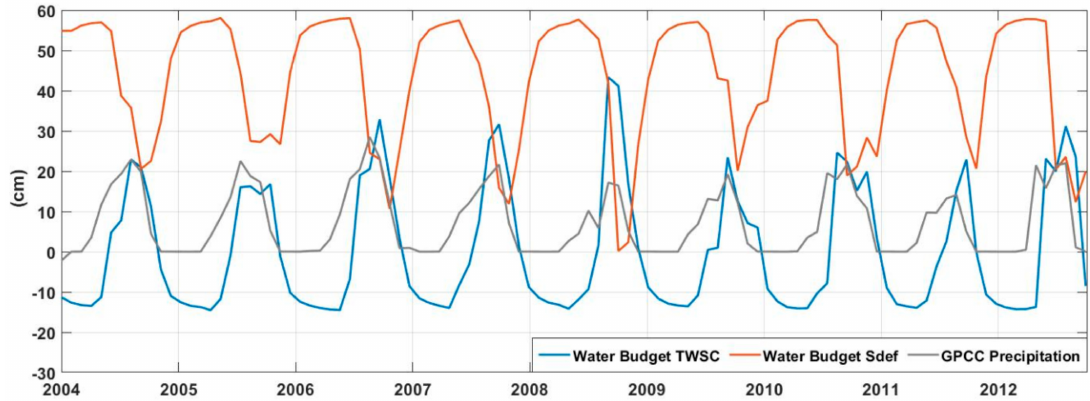
Figure 8. Variations in time series of monthly water budget TWSC, storage deficit and precipitation at the location of longitude 12.5 and latitude 9.5 from 2004 to 2012.